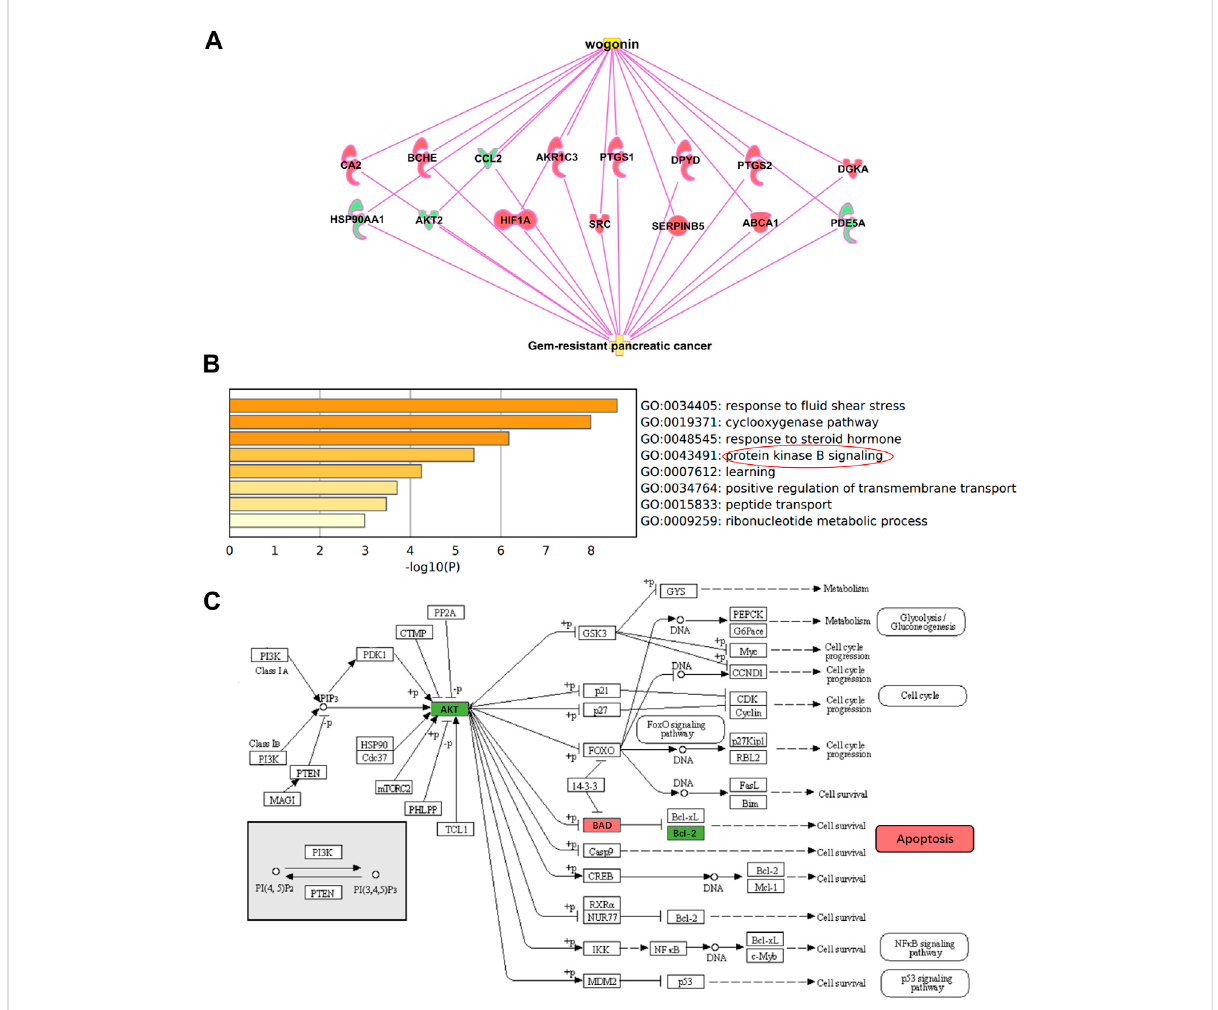
FIGURE 3 Potential mechanism ofwogonin sensitization (A) “ wogonin-target-gemcitabine resistance ” network map. Wogonincanenhancegemcitabine sensitivitybydownregulatingAKT2. (B) Goenrichmentanalysisof15DEGs,whichwereenrichedinproteinkinaseB(Akt)signaling. (C) Hypothesison the sensitization mechanism of wogonin to gemcitabine in pancreatic